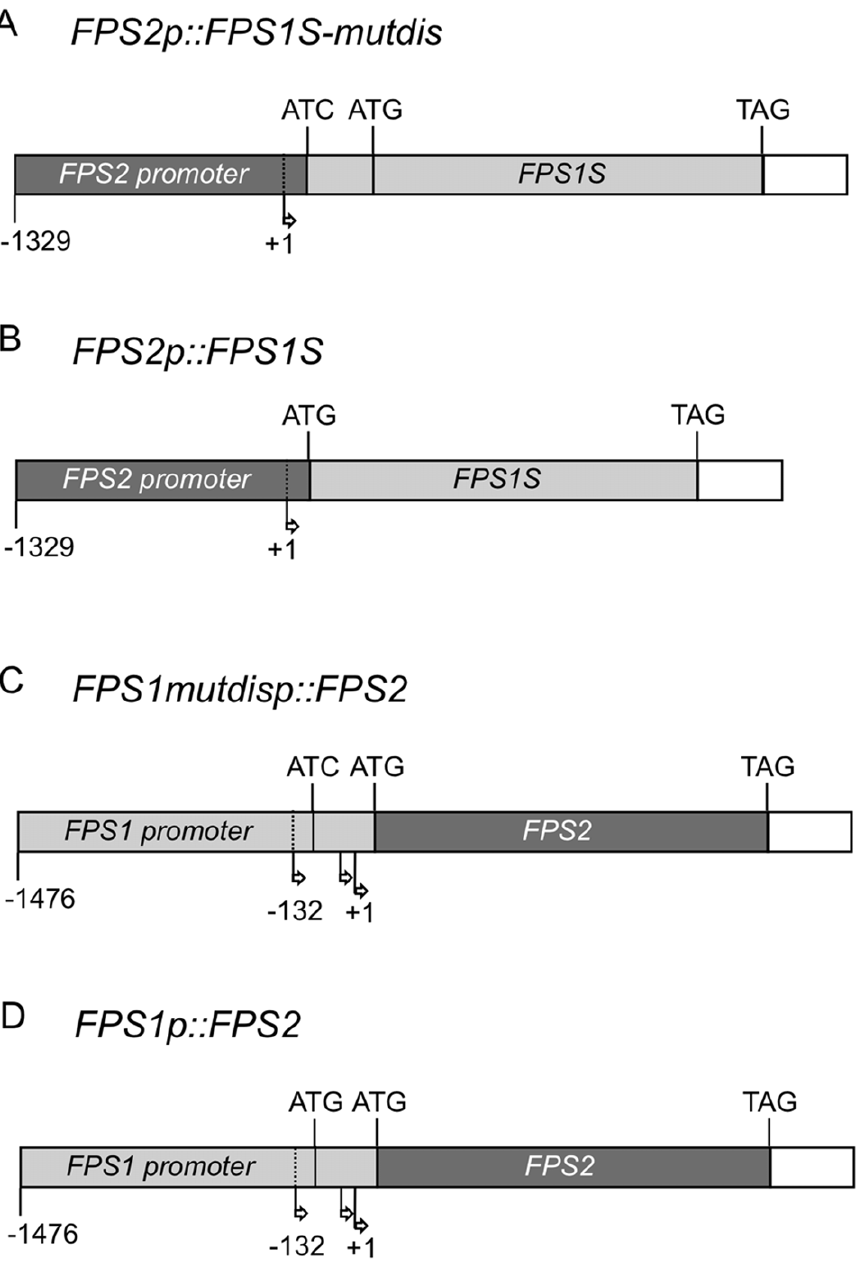
Figure 7. Schematic representation of chimeric genes FPS2p::FPS1-mutdis (A), FPS2p::FPS1S (B), FPS1mutdisp::FPS2 (C) and FPS1p::FPS2 (D). Dark gray boxes represent FPS2 genomic sequences whereas sequences corresponding to FPS1 gene are represented by light gray boxes. In all constructs the 3 9 -untranslated regions of both FPS genes is represented by an empty box. The position of the translational start codons is indicated as ATG and that of stop codons is indicated as TAG. In the FPS2p::FPS1S-mutdis (A) and FPS1mutdisp::FPS2 (C) constructs, the 5 9 -most ATG codon in exon 1 of the FPS1 gene was mutated to an ATC codon (encoding Ile). Arrows indicate the transcription start sites. In the FPS1 gene, position + 1 was assigned to the most internal transcription start site.